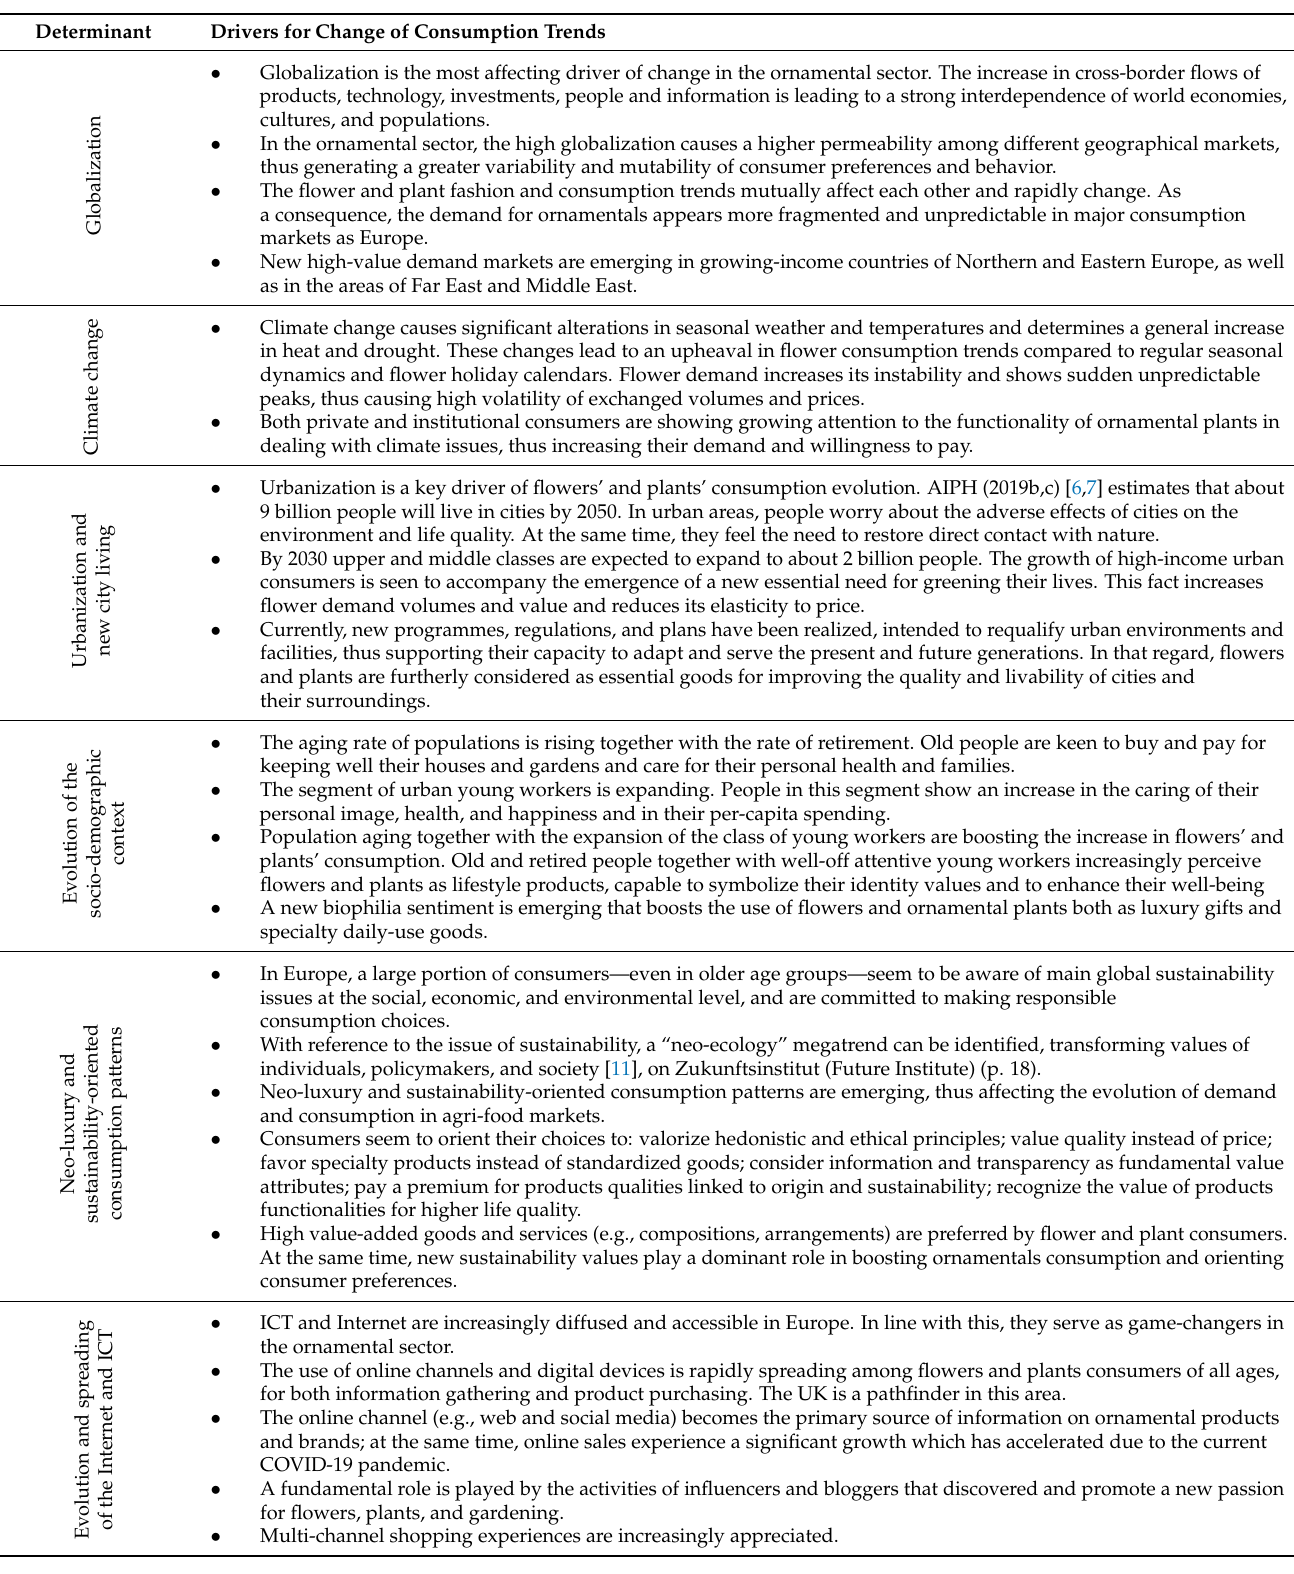
Table 5. Main determinants affecting the evolution of flower and plant consumption trends in